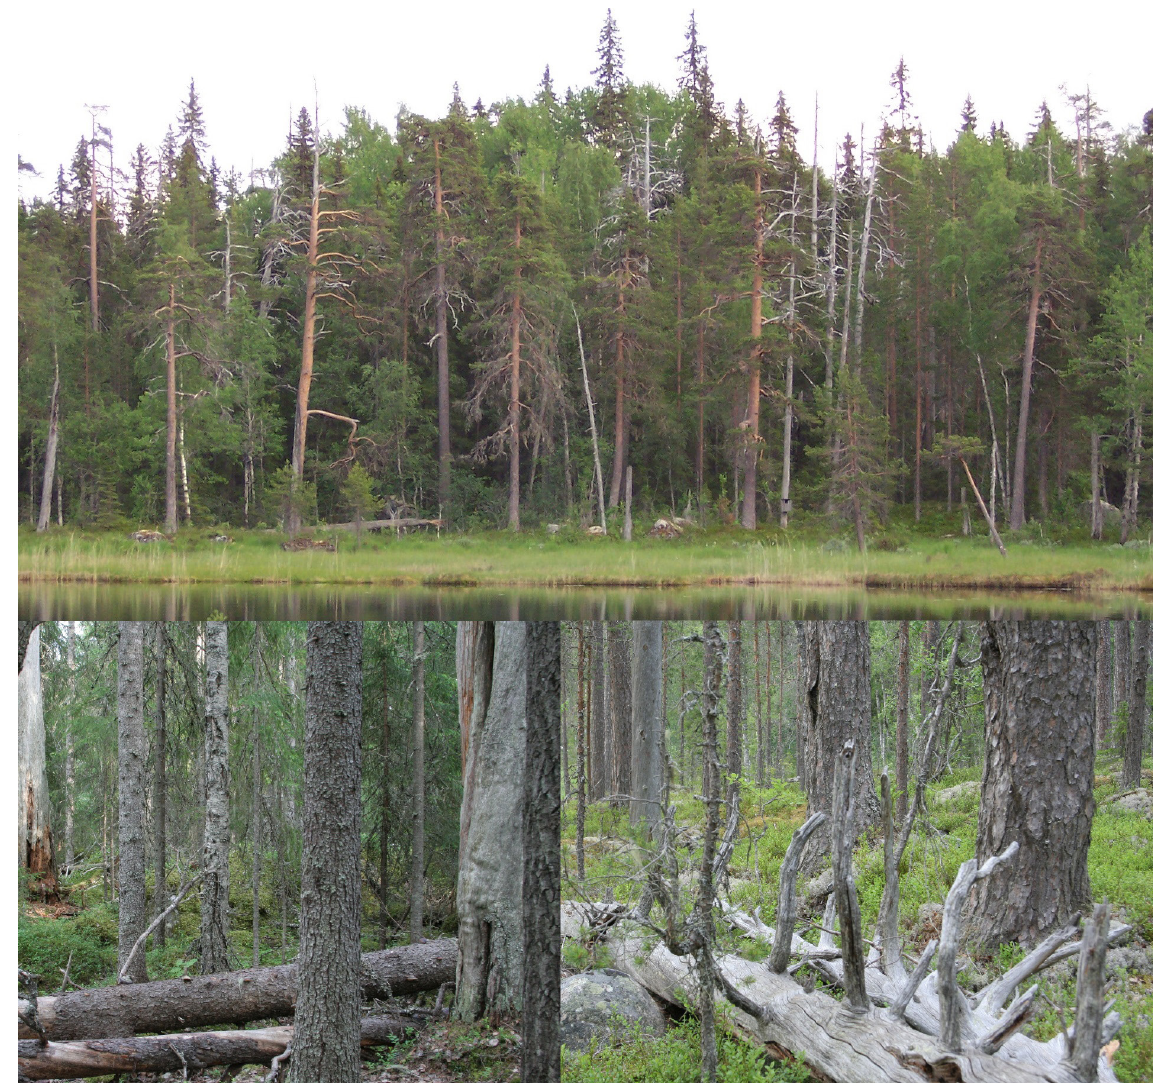
Fig. 10. Ensjölokarna in the province of Hälsingland, Sweden. One of a few fragments of primeval forest that remains in Central Sweden. Habitat of Nexorides collaris (Gravenhorst, 1829), N. montanus (Oehlke, 1966) and N. striatus Johansson sp. nov. Photo: Maria von Hofsten and Länsstyrelsen i